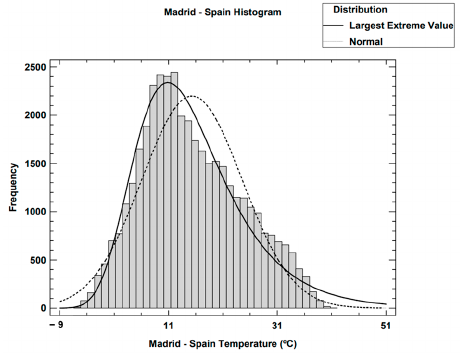
Figure 6. Madrid—Spain distribution fi tt ings and histogram.